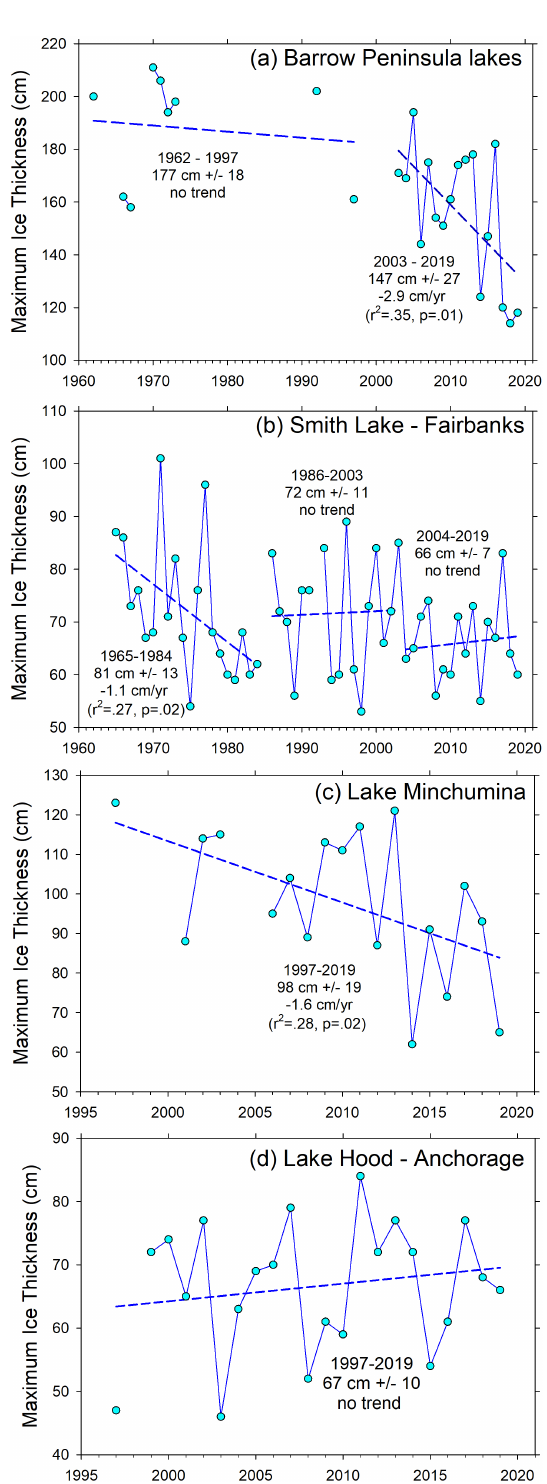
Figure 5. Maximum ice thickness patterns and trends for lakes around the Barrow Peninsula (a) , Fairbanks (b) , Minchumina (c) , and Anchorage (d) for each station’s period of